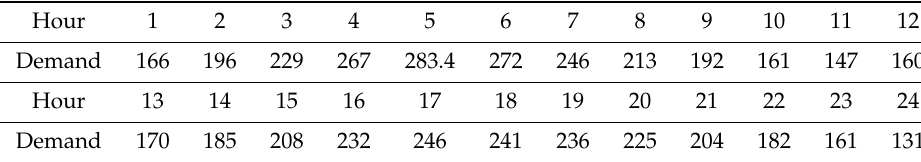
Table 6. 24-hour load demand for 6-unit system.